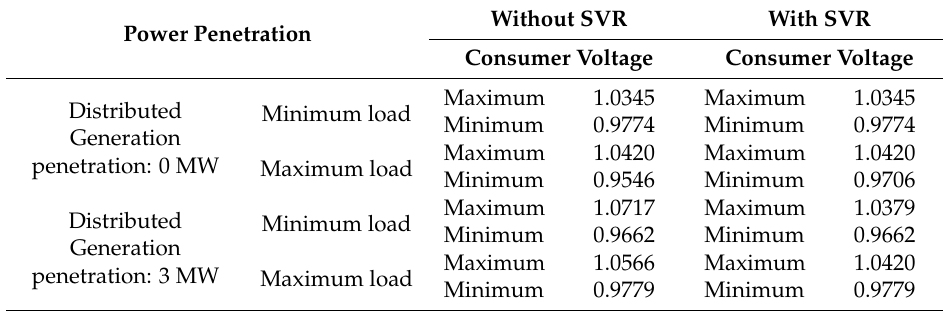
Table 5. Existing distributed generation (DG) penetration, and step voltage regulators (SVR) installation voltage